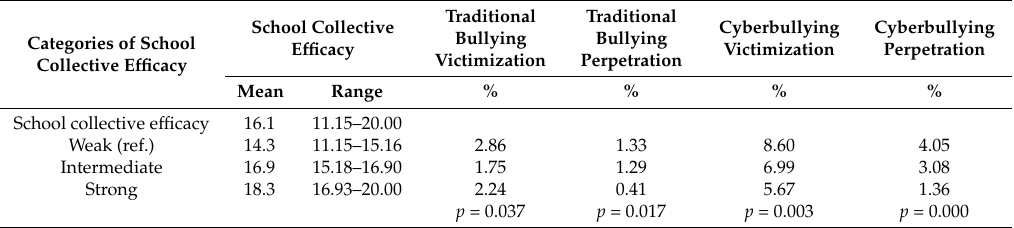
Table 3. Mean values and ranges of school collective efficacy, and proportions of students reporting